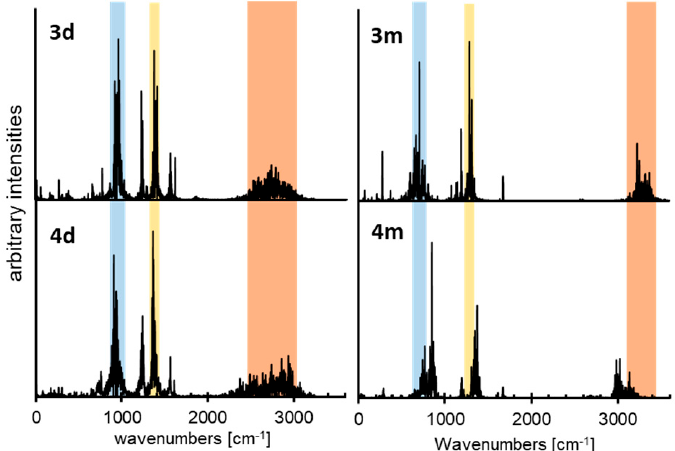
Figure 12. Calculated power spectra of atomic velocity–results of the CPMD runs for the monomers of 3 and 4 ( 3m and 4m ) as well as for the dimers of 3 and 4 ( 3d and 4d ). The CPMD power spectra are presented only for the bridged protons vibrational modes. The stretching vibration area is shown in red. The bending vibration areas are shown in blue and yellow.